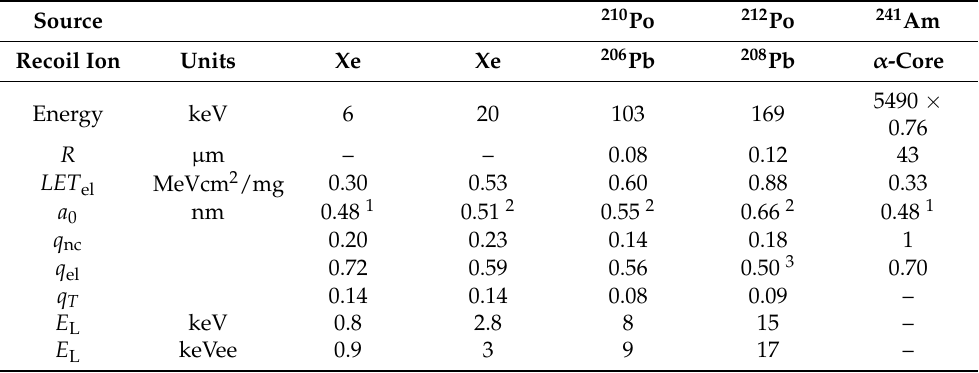
Table 3. Quenching factors q T , q nc and q el and the energy available for scintillation, E L , estimated for Xe recoils and Pb recoils in α -decay in liquid xenon. The q nc values for Xe recoils are from Lindhard ( k = 0.165) [23] and those for Pb recoils were obtained by the semi-empirical power-law approximation. Birks’ law was exploited for obtaining q el values. Related values for 241 Am α -core are also listed. E L (keVee) = E L / L γ 0 (keV) = E L /0.89 (keV). Source 210 Po 212 Po 241 Am Recoil Ion Units Xe Xe 206 Pb 208 Pb α -Core Energy keV 6 20 103